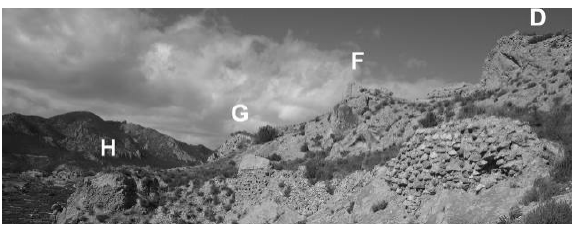
Figure 15. View of the lower enclosure from Tower